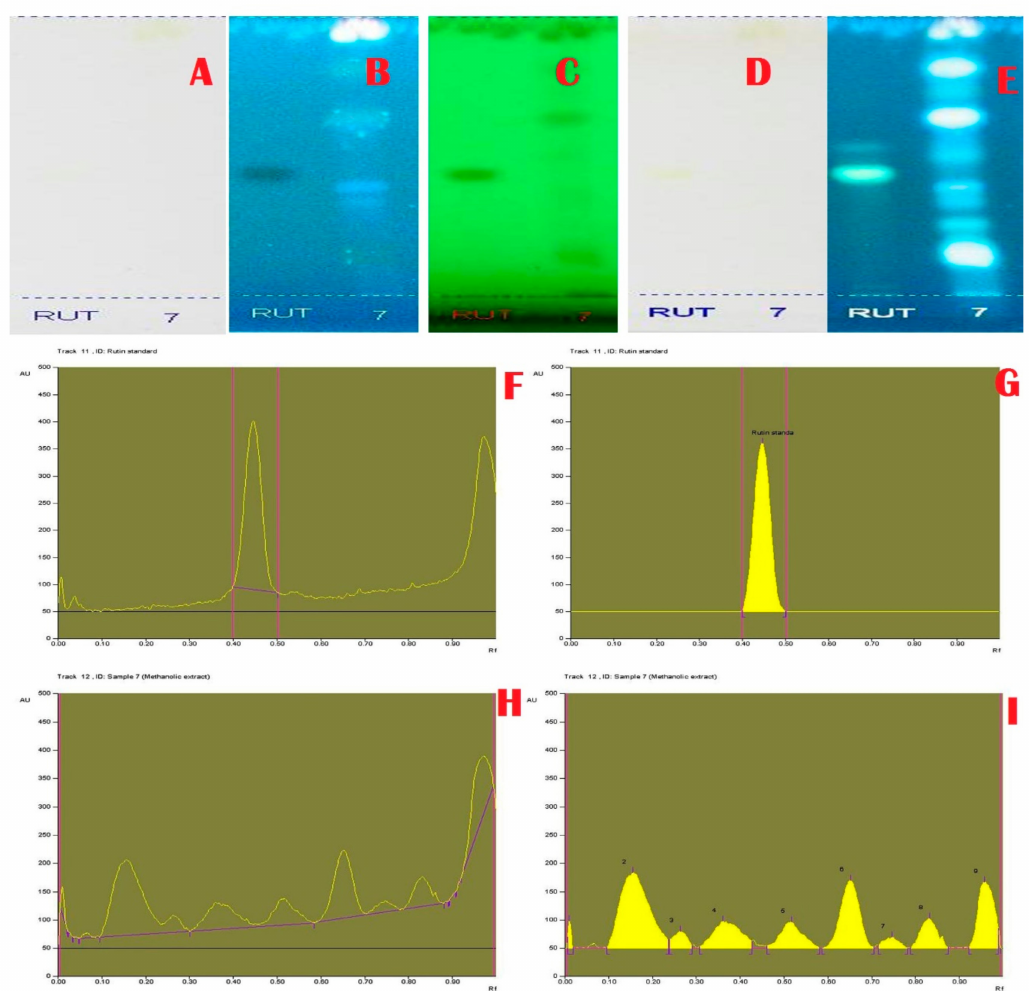
Figure 2. Flavonoid Specific Profile and Chromatogram of A. aethiopicum. ( A ): HPTLC profile of A.aethiopicum under visible light; ( B ): HPTLC profile of A. aethiopicum under UV light at 366 nm before derivatization; ( C ): HPTLC profile of A. aethiopicum under UV light at 234 nm before derivatization; ( D ): HPTLC profile of A. aethiopicum under visible light after derivatization; ( E ): HPTLC profile of A. aethiopicum under UV light at 366 nm after derivatization; ( F ): HPTLC chromatogram of ethanolic extracts of A. aethiopicum —base line display scanned at 254 nm; ( G ): HPTLC chromatogram of ethanolic extracts of A. aethiopicum —peak densitogram display scanned at 254 nm; ( H ): HPTLC profile of standard Rutin—peak baseline display scanned at 254 nm; ( I ): HPTLC chromatogram of standard Rutin—peak densitogram display scanned at